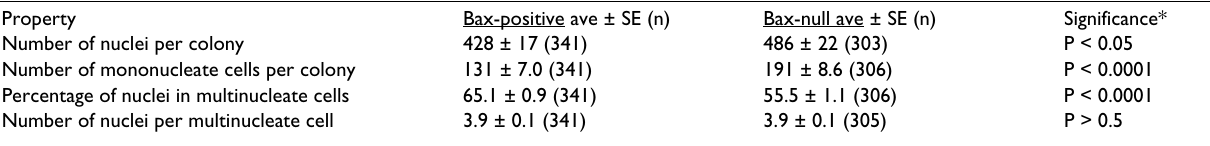
Table 1: Effect of Bax genotype on properties of muscle colonies formed by the progeny of individual myogenic cells in vitro .